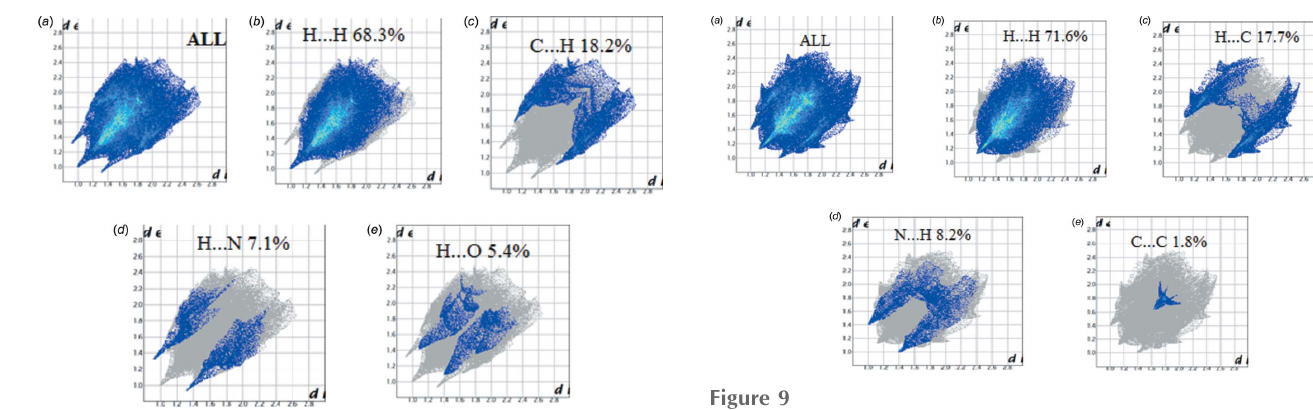
Figure 8 Two-dimensional fingerprint plots for compound (I): ( a ) all inter- molecular interactions; ( b ) H (cid:2)(cid:2)(cid:2) H contacts; ( c ) C (cid:2)(cid:2)(cid:2)(cid:2) H contacts; ( d ) H (cid:2)(cid:2)(cid:2) N contacts; ( e ) H (cid:2)(cid:2)(cid:2) O contacts.